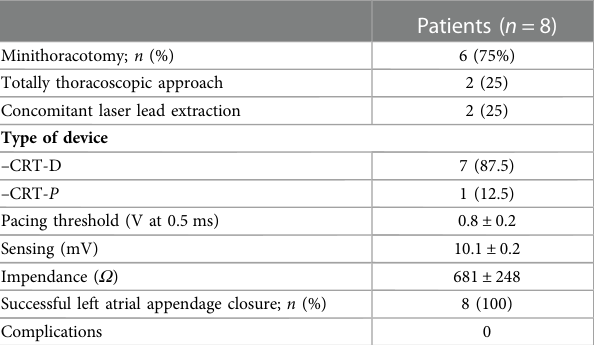
TABLE 2 Results and